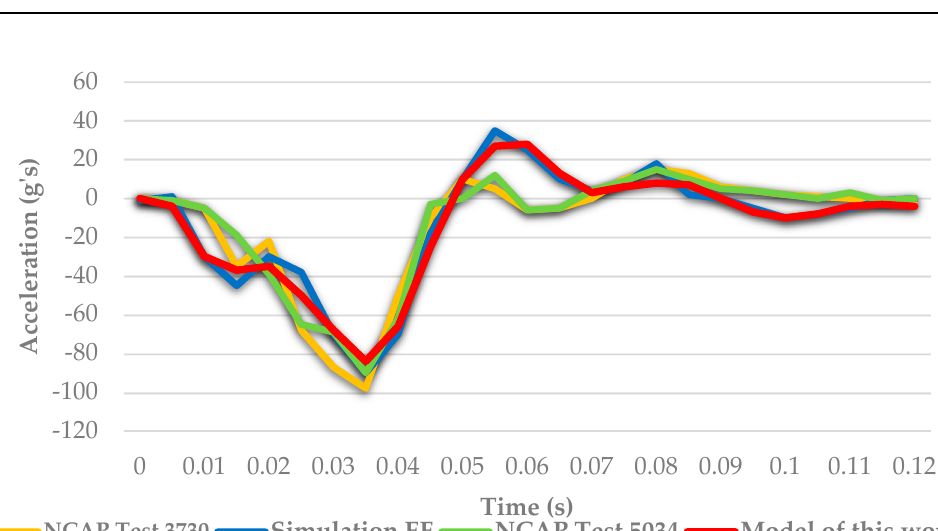
Figure 3. George Washington University acceleration report of the upper part of the engine on the X -axis compared with the model of this